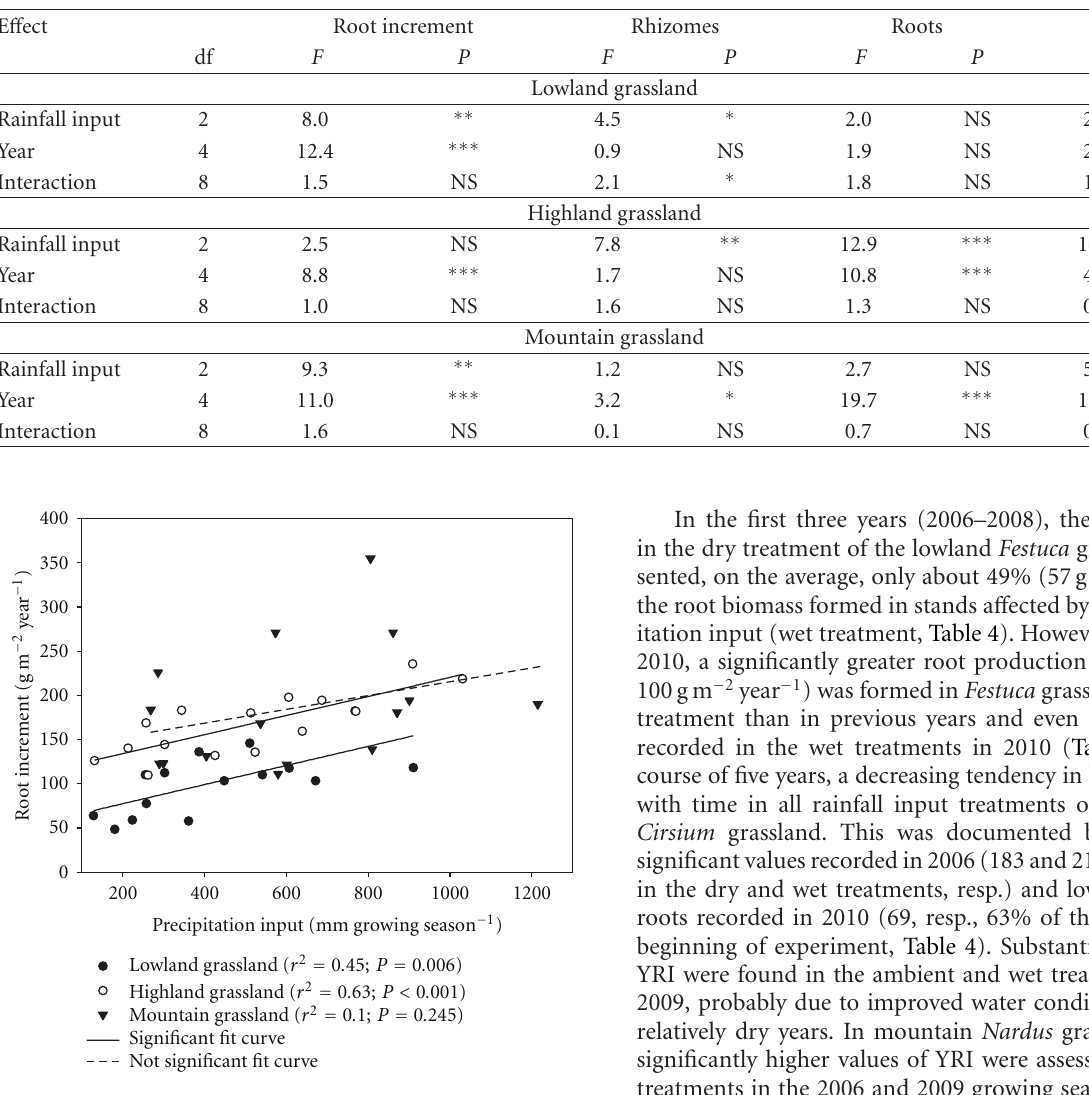
Figure 2: Relationship between the yearly root increment and pre- cipitation input along the experimental precipitation gradient. Each point indicates annual